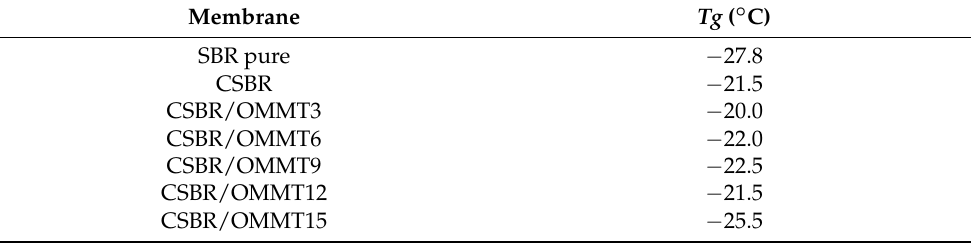
Table 4. Glass transition temperatures of SBR and SBR/OMMT